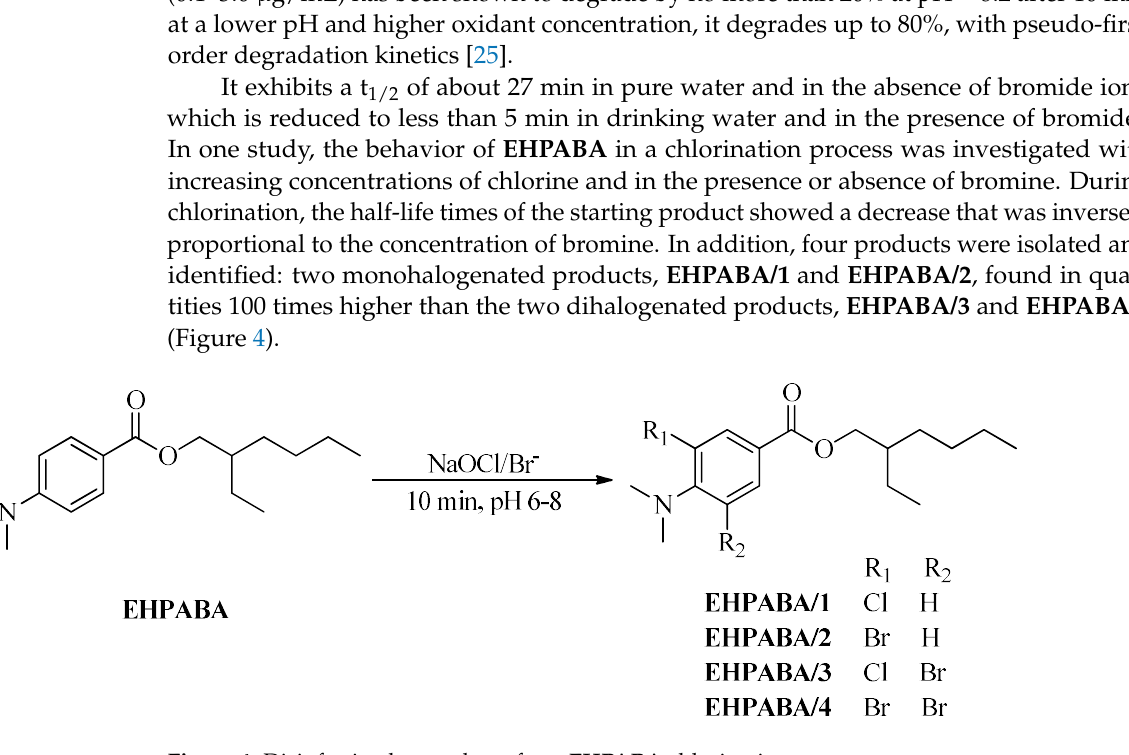
Figure 4. Disinfection by-products from EHPABA chlorination.